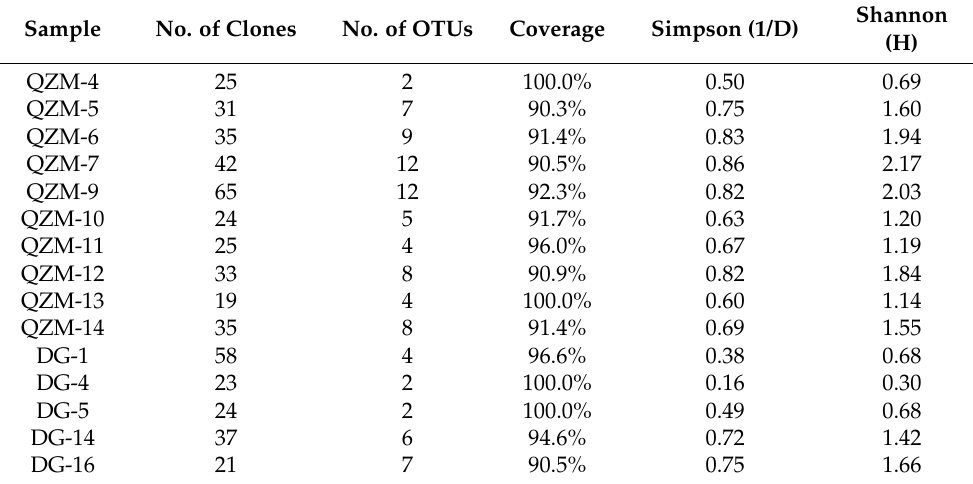
Table 2. Ecological estimates of the dsrB gene libraries of the investigated hot spring sediments in this